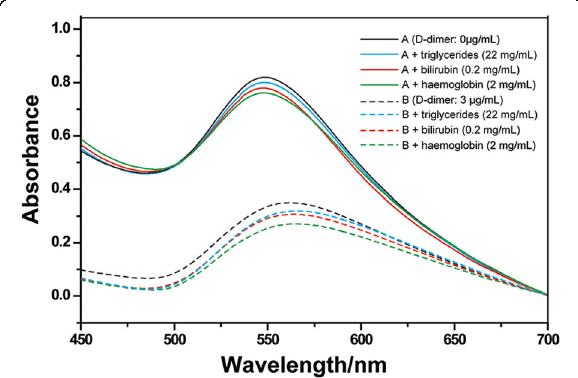
Fig. 6 The SPR spectra of anti-D-dimer antibody-PSS-MA-GoldMag after reaction with D-dimer samples in the presence and absence of triglycerides, bilirubin, and